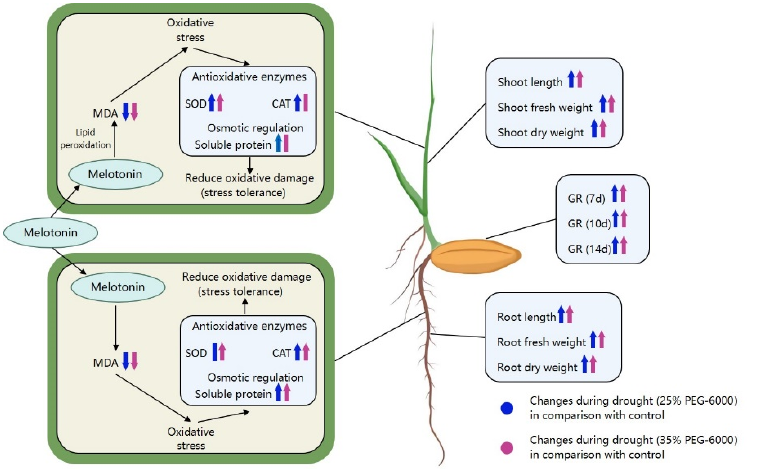
Figure 10. Schematic diagram showing the changes of morphophysiological parameters in response to 100 μ M melatonin to relieve drought stress in rice seed germination. Symbols such as ( ↑ ), ( ↓ ), and (|) represent upregulation, downregulation, and no significant changes to the various parameters, respectively.